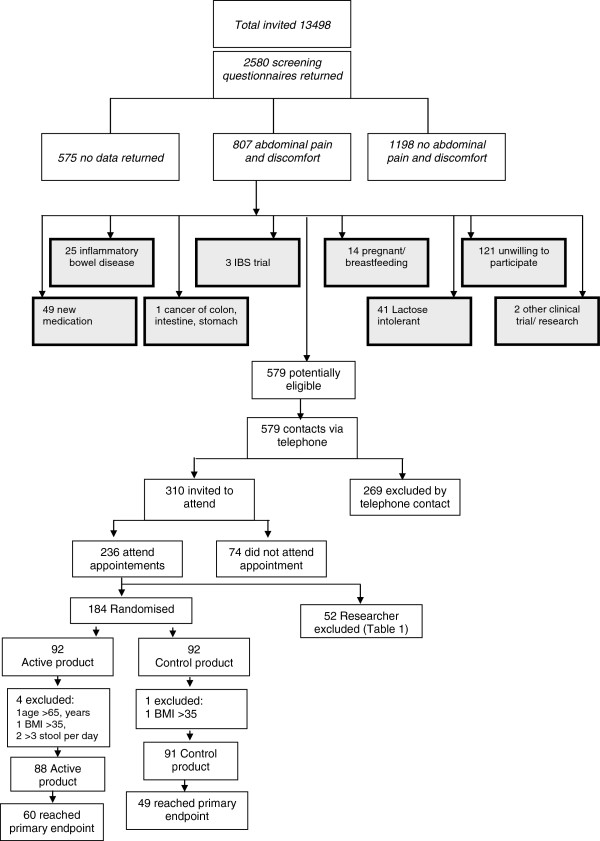
CONSORT diagram of recruitment, randomization & primary endpoint numbers.